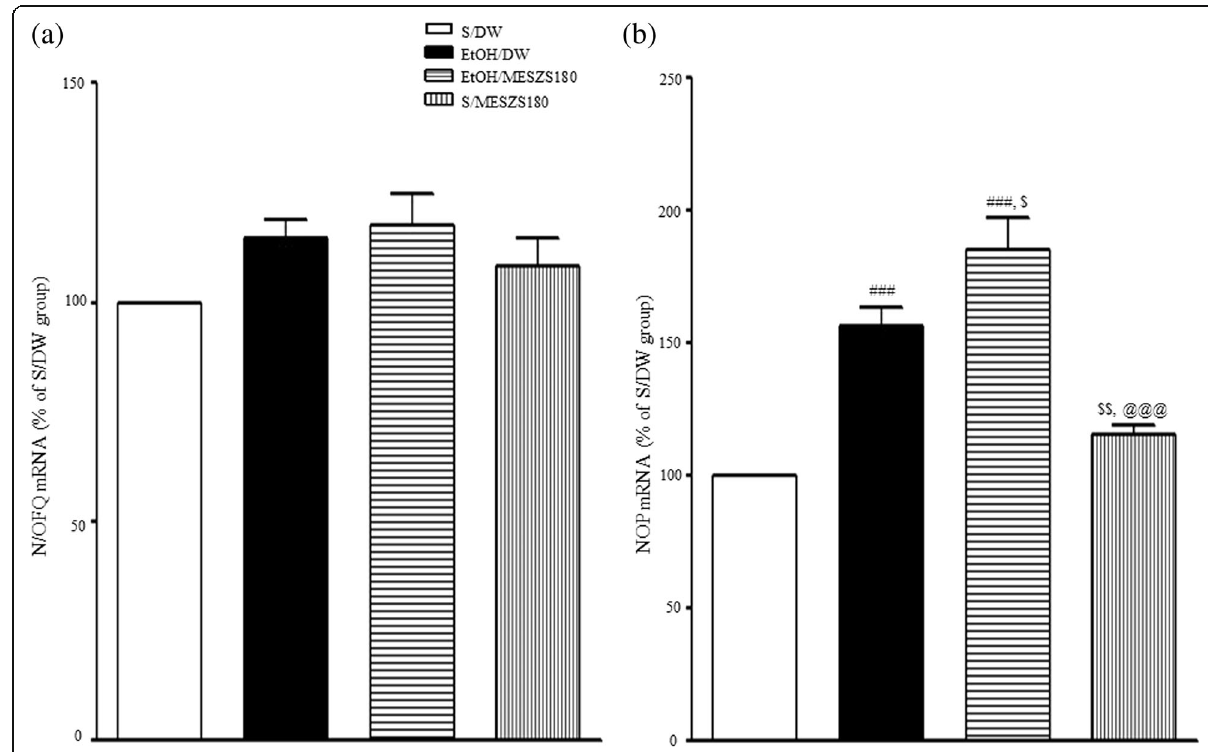
Fig. 7 Effects of MESZS on the mRNA expressions of amygdaloid ( a ) N/OFQ and ( b ) NOP during EtOHW. Immediately after the behavioral test, the mRNA levels of N/OFQ and NOP in the CeA were evaluated using qPCR analysis. All data are expressed as a mean ± SEM ( n = 5). S: saline, DW: distilled water, EtOH: ethanol, MESZS: methanol extract of Semen Ziziphi Spinosae , MESZS180: 180 mg/kg/d MESZS. ### p < 0.001 vs. S/DW group; $ p < 0.05, $$ p < 0.01 vs. EtOH/DW group; @@@ p < 0.001 vs. EtOH/MESZS180 group (one-way ANOVA followed by Newman-Keuls post hoc